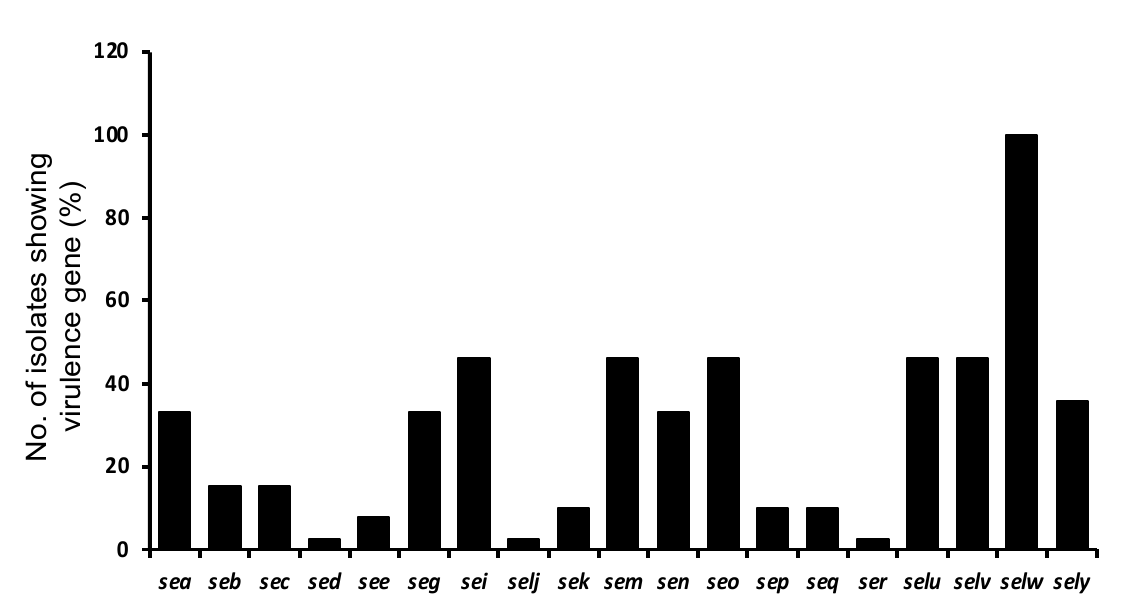
Figure 2. Distribution of different SE and SEl genes among the S. aureus isolates from wholesale and retail pork in Wuhan, central China.